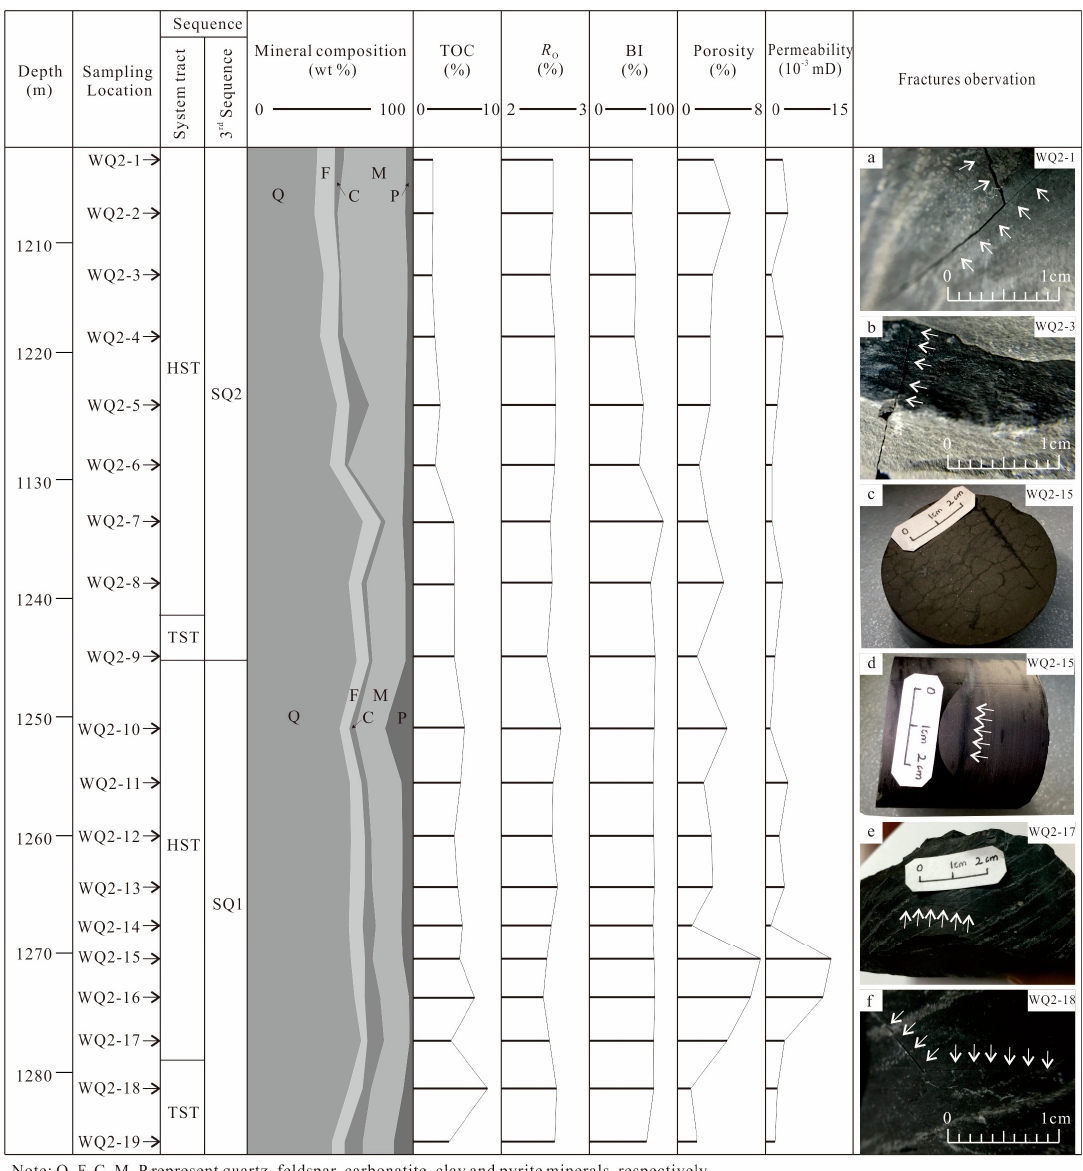
Figure 5. Vertical variations in the mineral composition, total organic carbon (TOC), vitrinite reflectance ( R o ), and brittleness Index ( BI ) of the LSL shales of Well-WQ2. TST = transgressive system tract; HST = high-stand system tract. ( a , b , f ) Well-developed fractures illustrated by microfocus photography; ( c , d ) Microfracture system shown saturating the core with distilled water; ( e ) Developed fracture with a width of ~0.1 mm.